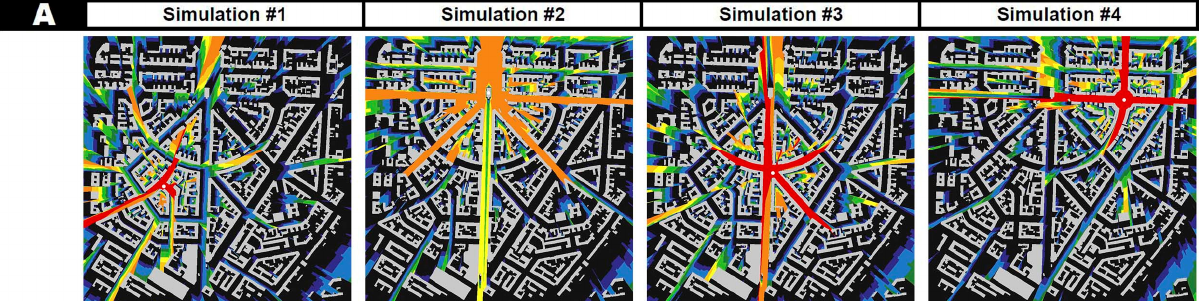
Figure 7. VIS simulations for area “A” (Berlin Friedenau)